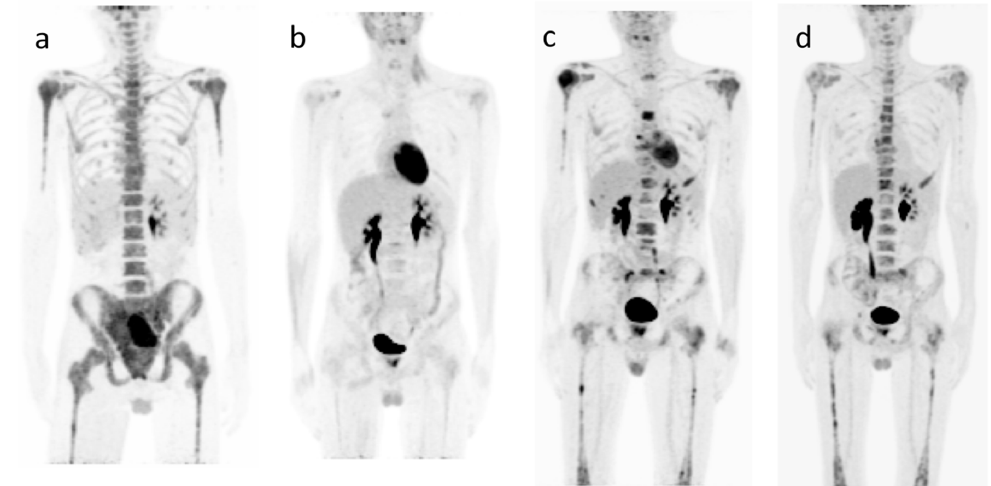
Figure 2. Patient 2. An 18-year-old boy entered the pediatric emergency room with abdominal pain and occlusive symptoms. Contrast-enhanced CT documented bilateral sub-cent metric lung micro-nodules and a lesion with maximum diameters of 15 × 8 × 10 cm in the right median-paramedian pelvic region, surrounding the right arteriovenous iliac axis and the ipsilateral ureter with associated hydroureteronephrosis. Concomitant lymphadenopathies were observed along the left iliac axis, in the external iliac region of the same side, and at the ipsilateral inguinal level. Areas of cortical-subcortical bone-rarefaction suspected of metastasis in the sternum, shoulder blades, femoral necks, and wedge deformation of the 9th thoracic vertebra were reported as well. ( a ) A staging 18 F-FDG PET-CT [8,9] was therefore performed. Maximum intensity projection showed a high glucose uptake both to the known right pelvic mass (SUVmax 13.5 and SUVmax lesion/SUVmax liver = Tumor Liver Ratio (TLR) >4.6), to the level of common and right internal and external iliac lymph nodes, and to other lymph nodes of the obturator region of the same side. Finally, the scan documented an intense bone marrow uptake that involved multiple sites, especially spine and pelvis, but also upper and lower limbs and a diffuse uptake to testes. As collateral findings, increased FDG uptake was evident to the 9th thoracic vertebra and to the right kidney due, respectively, to recent neurosurgical intervention (diagnostic laminectomy) and to functional renal failure treated with double J catheter placement. PET-CT results, i.e., a highly metabolically active primary tumor with a TLR greater than 4.6, together with the presence lower survival rates and were consistent with an aggressive metastatic oncological disease